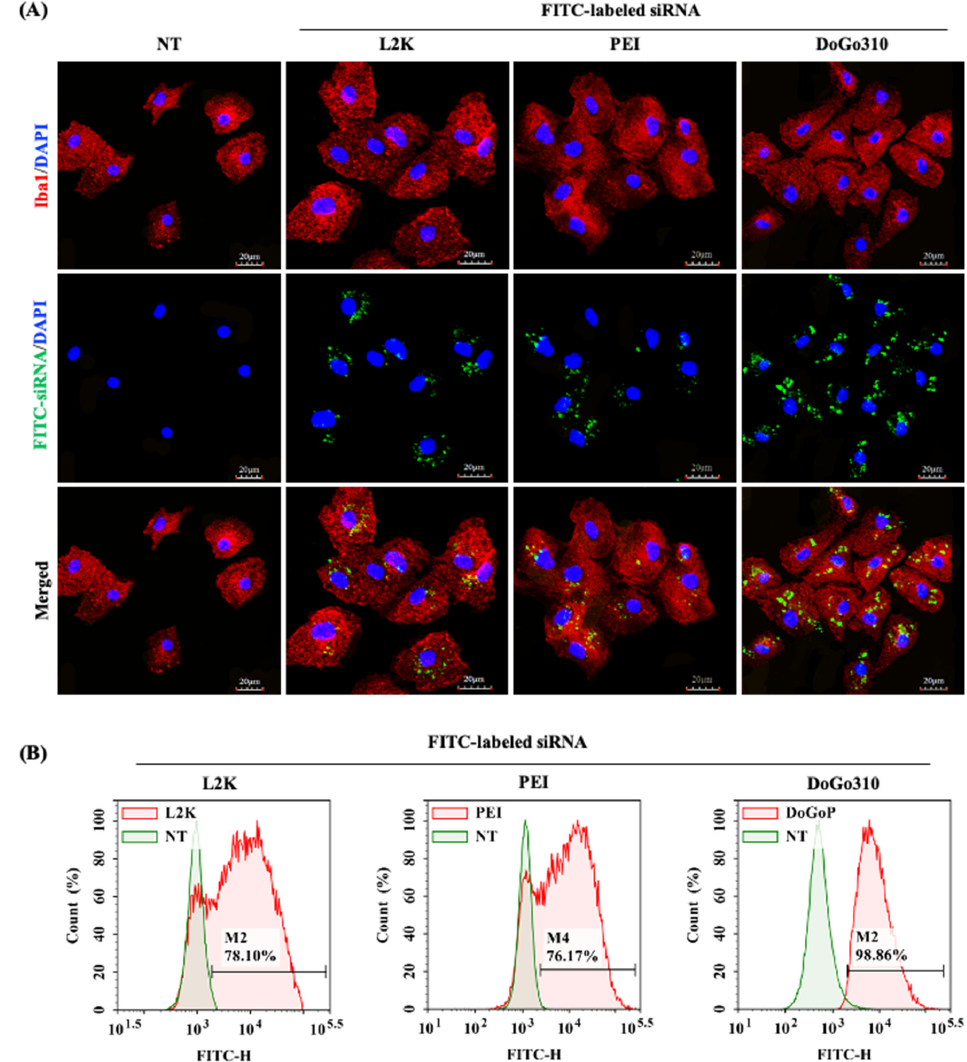
Figure 2. DoGo310 LNPs deliver fluorescently labeled siRNA more efficiently compared to Lipofec- tamine 2000 (L2K) and PEI. ( A ) Confocal images of Iba-1 positive mouse primary microglia treated with FITC-siRNA/L2K, FITC-siRNA/PEI, or FITC-siRNA/DoGo310, respectively. Red, anti-Iba-1 antibody; blue, DAPI; green, FITC; NT, nontreated. Scale bar = 20 mm. ( B ) Quantification of FITC positive cells by flow cytometry.